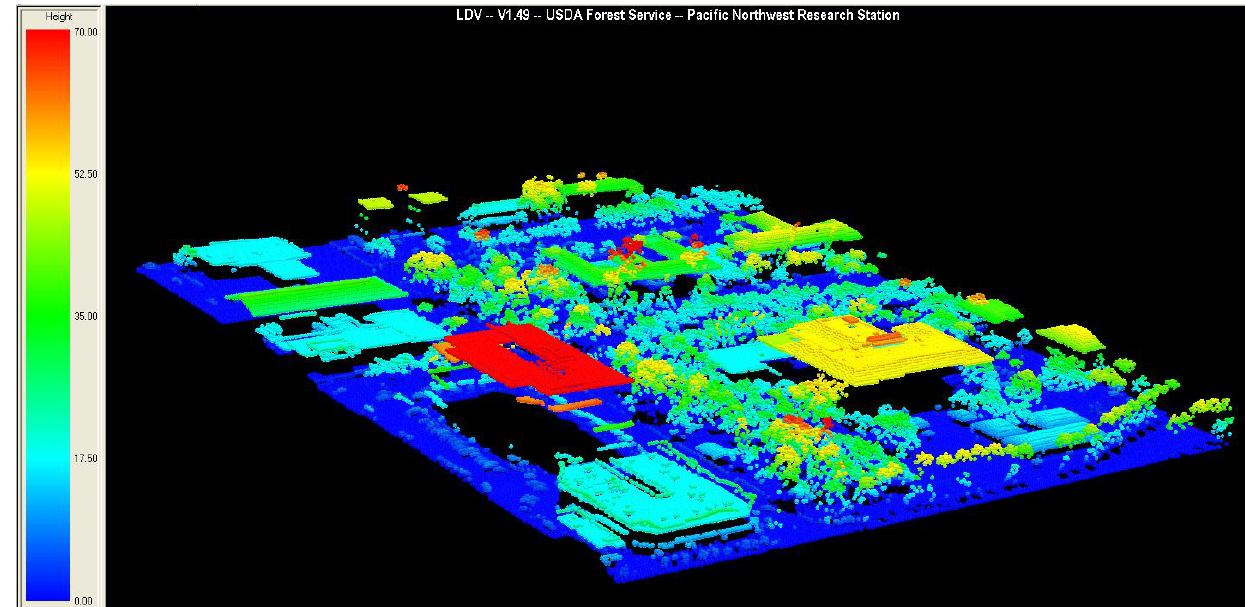
Figure 3. LiDAR point cloud image of elevation (ft) for a subset of the study area at the University of Arizona campus. Buildings and trees are easily recognized by their height, shape, and texture. The dark blue elevation values are generally used to create the